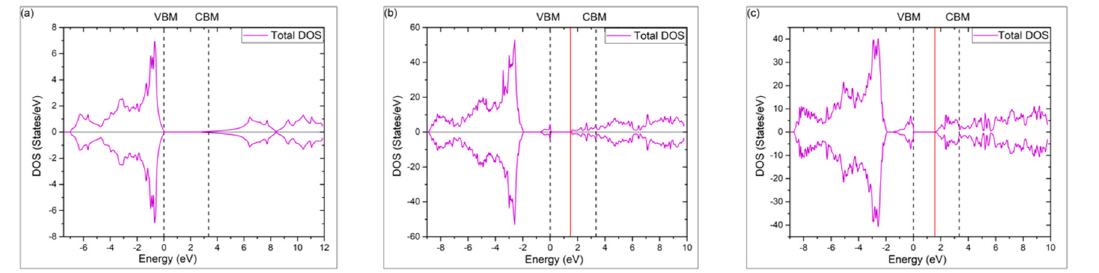
Figure 1. Total Density of States of ( a ) stochiometric SnO 2 ( b ) and ( c ) are Reduced SnO 2 (Sn 16 O 31 and Sn 16 O 29 ,